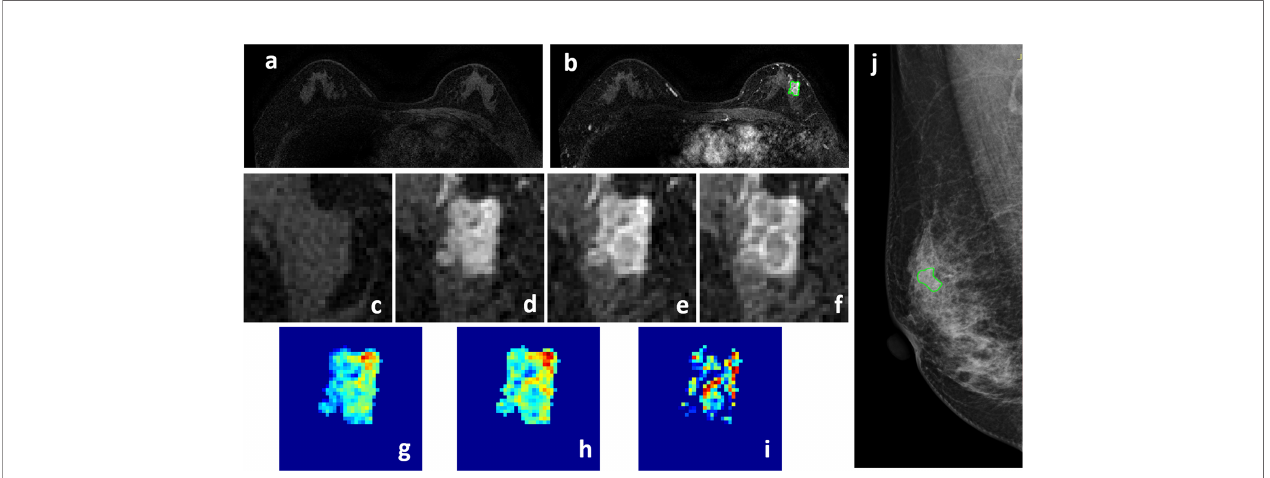
FIGURE 3 | A 58-year-old patient with ductal carcinoma in situ , showing a strongly enhanced heterogeneous 1.4 x 0.9 cm lesion, with MRI BI-RADS score of 5. (A) F1 Pre-contrast image. (B) F2 post-contrast image. (C – I) Magni fi ed images to demonstrate the margin and internal enhancements within the lesion. (C) F1 pre-contrast, (D) F2 post-contrast, (E) F3 post-contrast, (F) The last F6 post-contrast image. (G) The wash-in signal enhancement map F2-F1, (H) The F3-F1 signal enhancement map, (I) The wash-out F6-F3 map. (J) A suspicious BI-RADS 4A mass is seen on mammography. The lesion ROI is outlined with the guidance of MRI. The probability predicted by MRI, mammography, and combined radiomics models were: 0.53, 0.49, 0.62, respectively, true